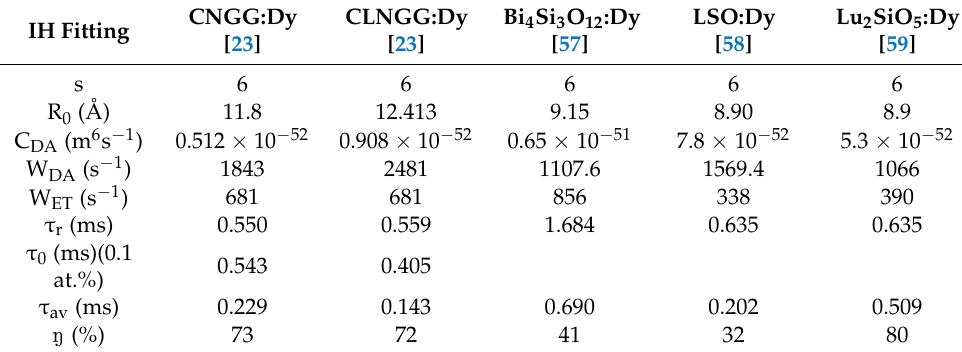
Table 10. Emission kinetic parameters of the 4 F 9/2 manifold of Dy 3+ ions in CNGG:Dy and CLNGG:Dy crystals.